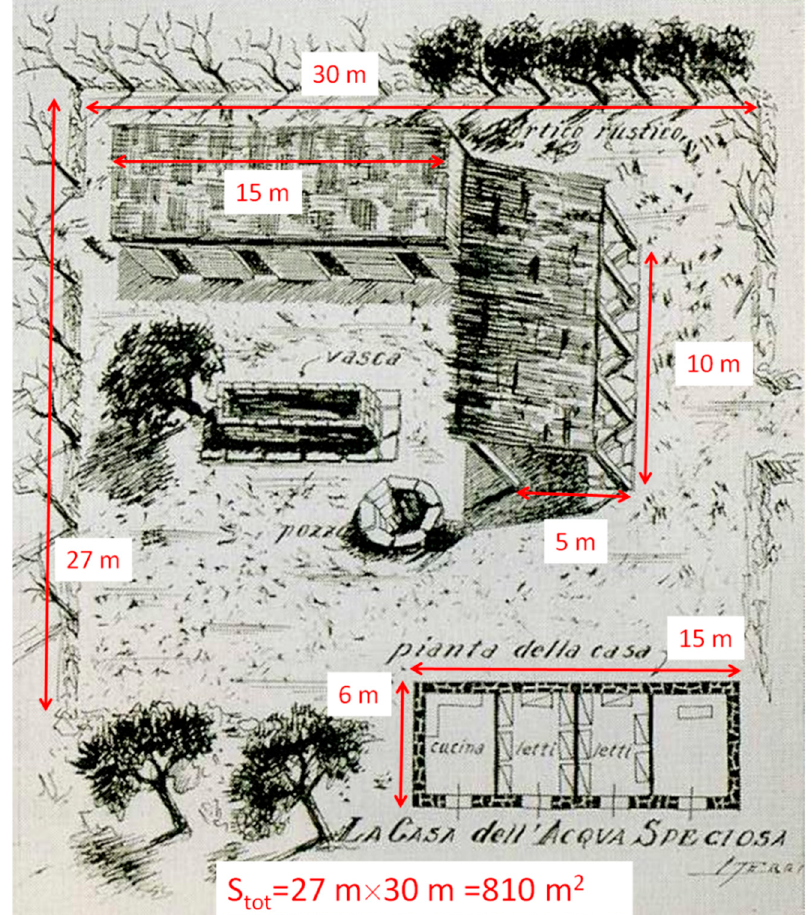
Figure 1. The outbuilding of the farm belonging to Lazarus, in the Jordan River Valley at about the same latitude of Ephraim, described in the EMV (118.1) at the locality referred to as the “Clear Water” ( La Casa dell’Acqua Speciosa ). Drawing by Lorenzo Ferri, made under the guidance of Maria Valtorta ([21], p. 204]. The dimensions reported in red have been estimated from the dimensions of the shed, 5 m × 10 m , explicitly indicated in a draft of the outbuilding reported in the same page.